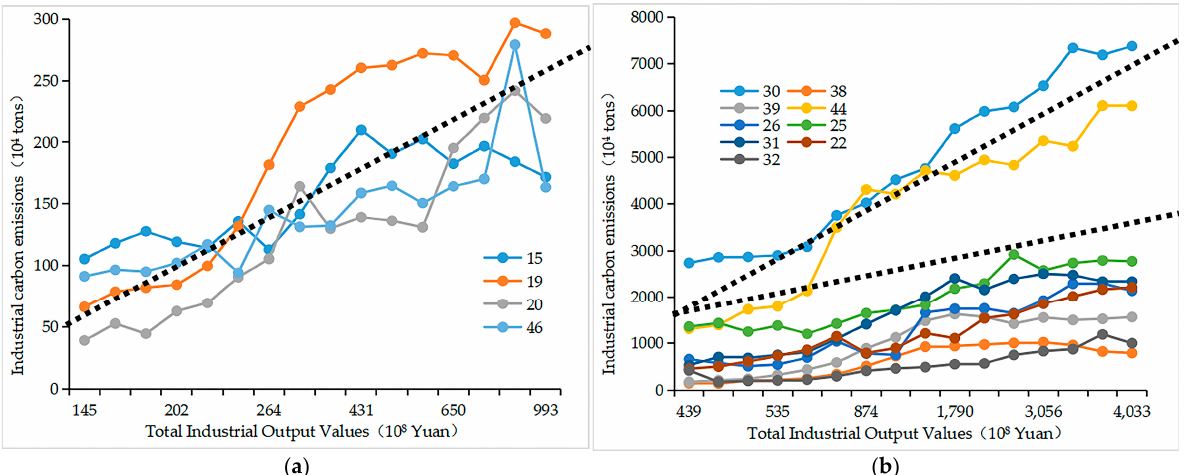
Figure 6. Relationship between the Total Industrial Output Values and the Carbon Emissions of the Industries of Steady Growth Type in Guangdong from 1998 to 2013. ( a ) industry codes: 15, 19, 20, 46; ( b ) industry codes: 22, 25, 26, 30, 31, 32, 38, 39,